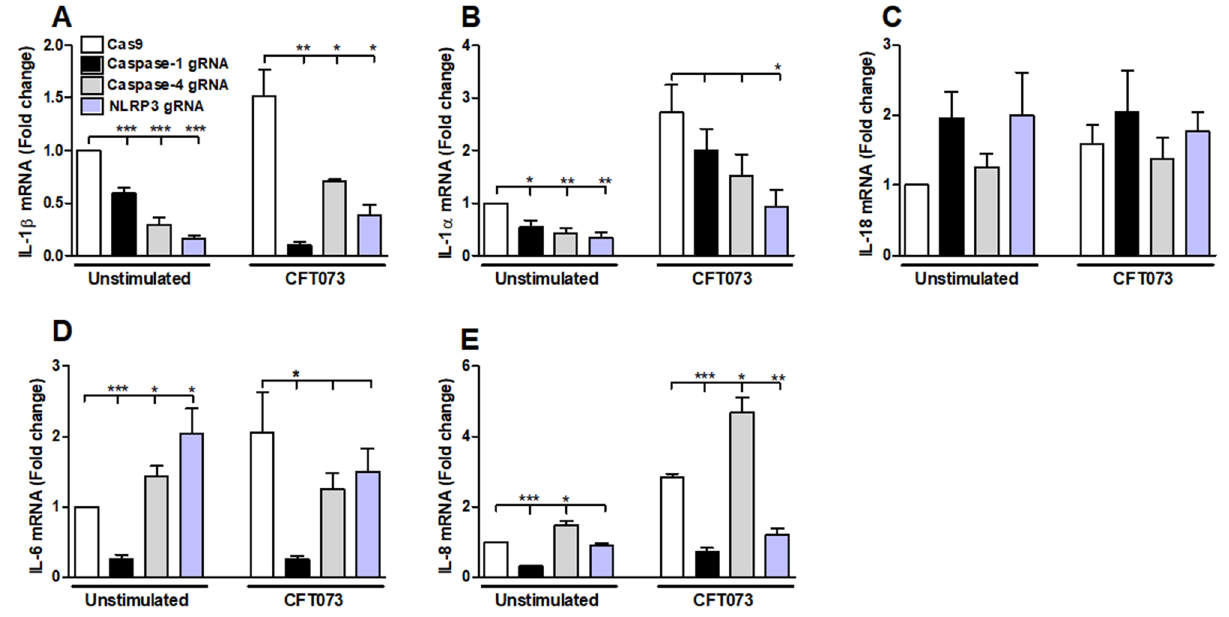
Figure 3. Gene expression of inflammasome-related genes. Caspase-1, caspase-4 and NLRP3-knockdown bladder epithelial cells and Cas9 controls were infected with CFT073 followed by analysis of mRNA expression of IL-1β ( A ), IL-1α ( B ), IL-18 ( C ), IL-6 ( D ) and IL-8 ( E ). The gene expression was normalized to GAPDH and expressed as fold change relative to unstimulated controls. gRNA stands for guideRNA targeting specific gene using CRISPR/Cas9. Data are presented as mean ± SEM of three independent experiments. Asterisks denote statistical significance compared to Cas9 control cells (* p < 0.05, ** p < 0.01, *** p <